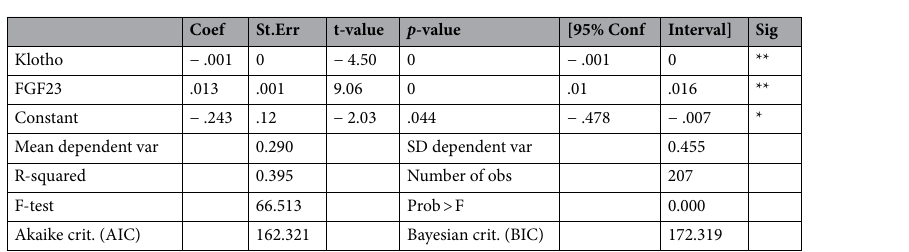
Figure 2. On the left, receiver operating characteristic (ROC) curves comparing the performance of a model without (Model 1) and with proteins (Model 2) in predicting MACE. The true-positive rate (sensitivity) is plotted as a function of the false-positive rate (1—Specificity). p < 0.001. On the right, receiver operating characteristic (ROC) curves comparing the performance of a model without (Model 1) and with proteins (Model 2) in predicting MALE. The true-positive rate (sensitivity) is plotted as a function of the false-positive rate (1—Specificity). p < 0.001.